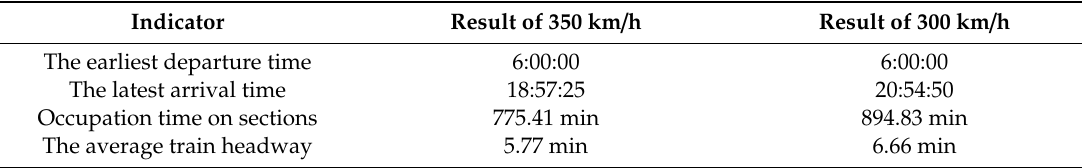
Table 10. Comparison of relevant indicators when di ff erent train